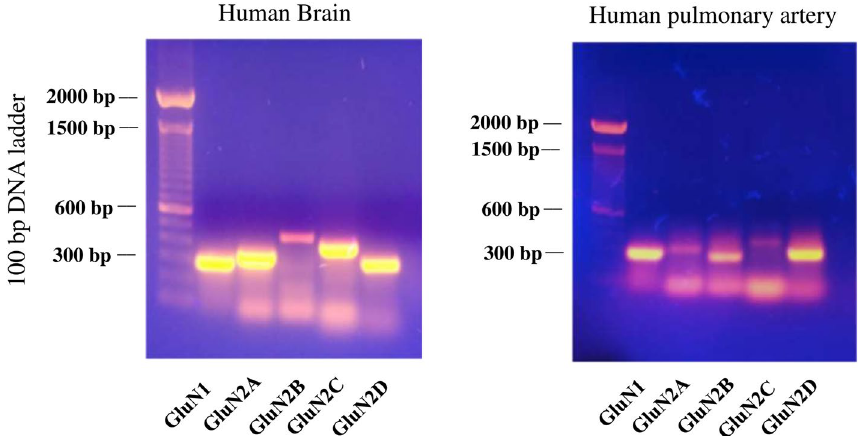
Figure 1. NMDA receptor mRNA expression in human pulmonary artery. RT-PCR was performed using RNA isolated from human pulmonary artery. The presence of mRNAs for GluN1 and all GluN2 subunits (2A–D) was detected in human pulmonary artery. Human brain RNA was used as a positive